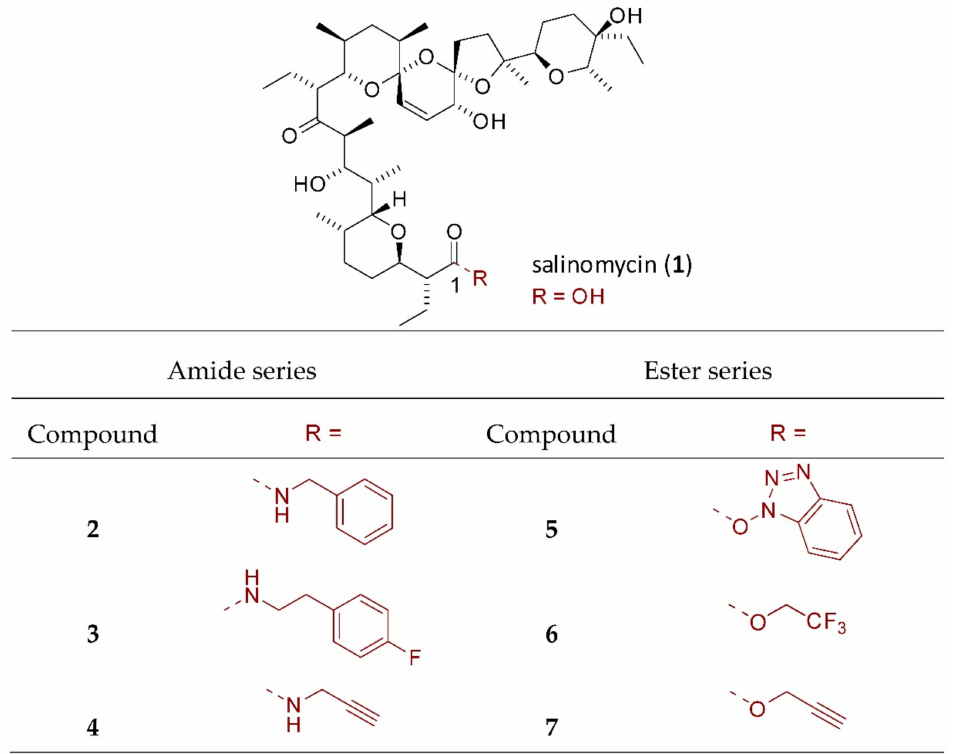
Figure 1. Structure of salinomycin and its derivatives studied in this